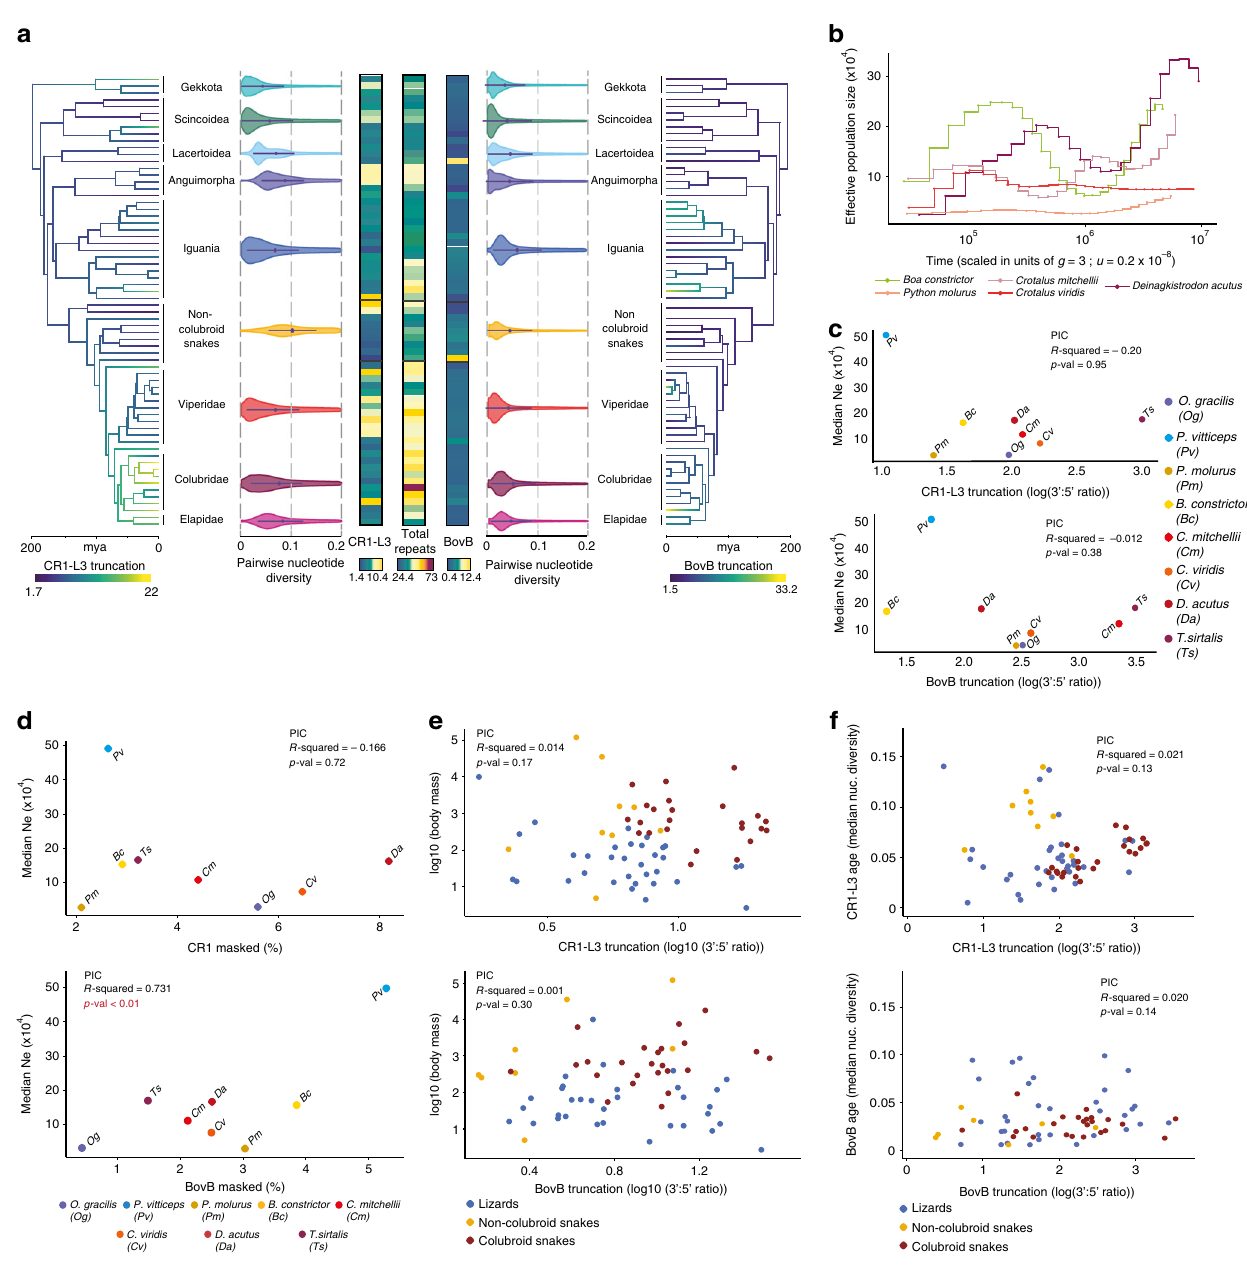
Fig. 4 Relationships between truncation, effective population size, body mass, and divergence estimates for CR1-L3 and BovB LINE retrotransposons among squamates. a Branches on the time-calibrated consensus phylogenies are colored according to the calculated 3 ′ :5 ′ read depth coverage ratio for CR1-L3 (left) and for BovB (right) LINEs. Heat maps show the genomic content of CR1-L3 LINEs, total repeats, and BovB LINE retrotransposons represented as percentages of the total genome. For each major clade, violin plots show the density distributions of divergence estimates (pairwise π ) for all CR1-L3 and BovB elements compared to the species-speci fi c consensus sequence. b Variation in effective population size ( N e ) over time for fi ve snake species scaled by generation time and mutation rate ( “ g ” and “ u ” on the x -axis). c Relationship between N e and truncation of CR1-L3 (top) and of BovB (bottom) LINEs for eight squamate species. d Relationship between total genomic abundance of CR1-L3 (top) and BovB (bottom) LINEs and N e . e Relationship between adult body mass and degree of truncation across 66 squamate species for CR1-L3 (top) and BovB (bottom) LINEs. f Relationship between age (median pairwise π ) and truncation for CR1-L3 (top) and BovB (bottom). Summary statistics from phylogenetically independent contrasts (PIC) are shown as insets for each plot in c – f . Statistical analyses were performed after log transformation of truncation values in plots e and f represent a very small fraction. Taken together, our data indicate vertebrates. The rami fi cations of such extreme levels of homo- that microsatellite seeding may be a common ancestral feature of logous SSRs in colubroid snakes, in terms of genome function and multiple families of squamate LINEs, yet the high activity and evolution, remains uninvestigated. A potential role in mediating expansion of CR1-L3 LINEs has driven associated AATAG loci to increased ectopic recombination leading to gene duplication has extremely high frequencies in colubroid snakes, leading to an been suggested by previous studies that have identi fi ed an astounding 74.73-fold genomic AATAG loci/Mbp increase in this enrichment of these repeats surrounding tandemly duplicated lineage, and the highest levels of genomic SSR content among venom genes in snakes 12,29,30 . Collectively, these fi ndings imply NATURE COMMUNICATIONS| (2018) 9:2774 |DOI: